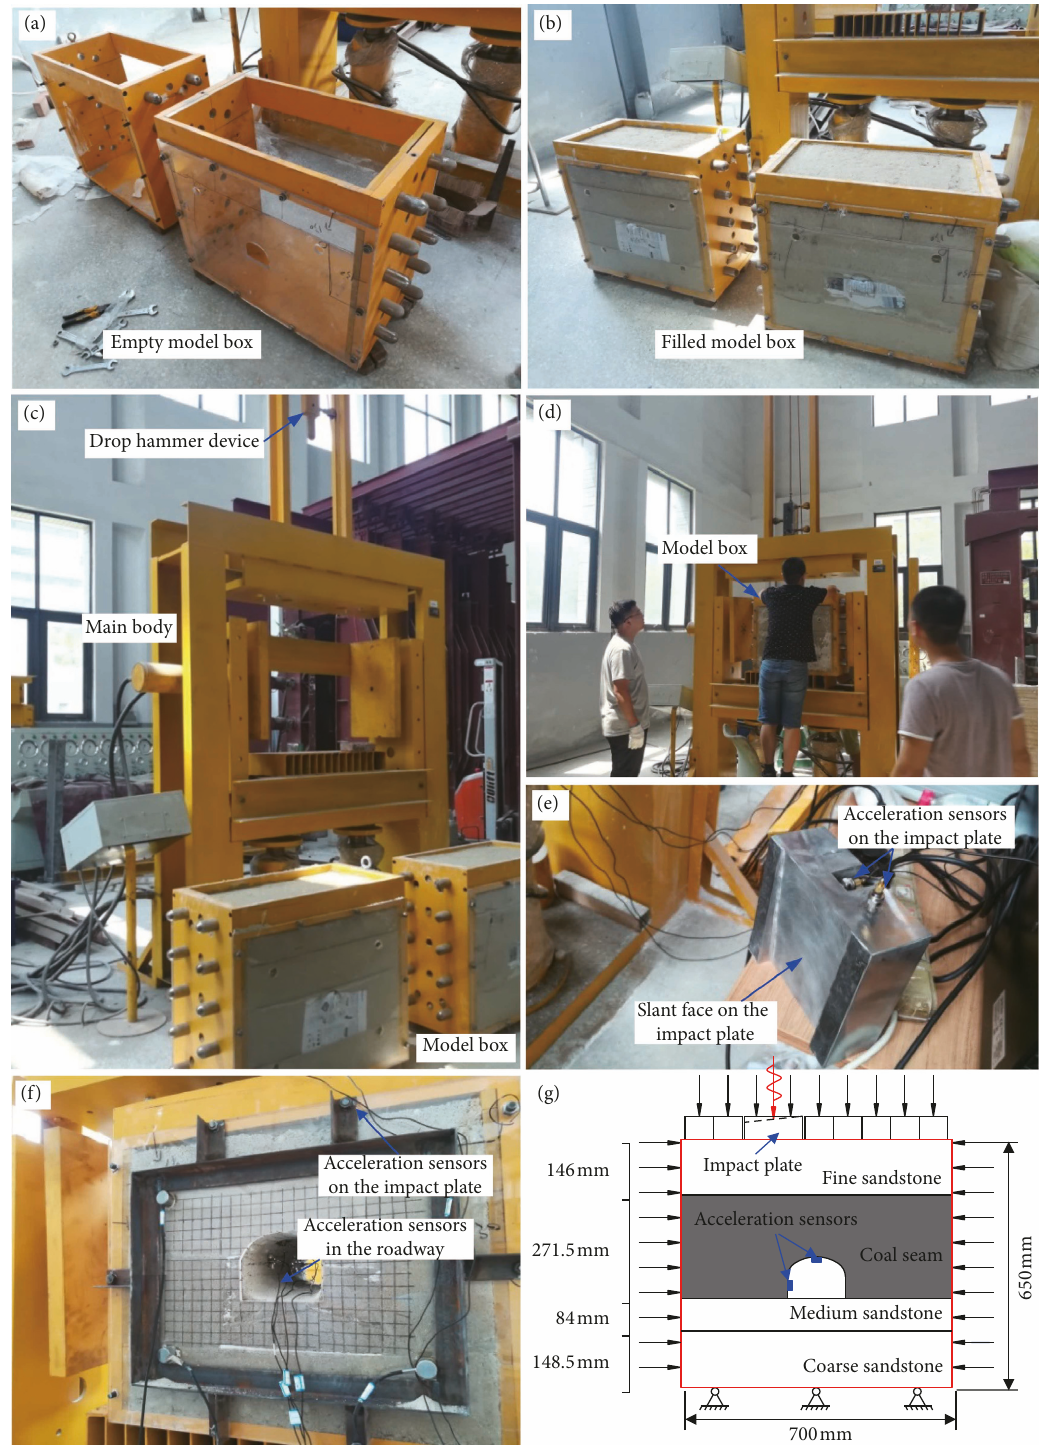
Figure 5: Model building procedure: (a) removing the empty model box from the facility, (b) filling the model box with model materials, (c) air-drying the model, (d) returning the model box to the facility, (e) putting the impact on top of the model, (f) installing sensors and applying loads, and (g) the schematic diagram of the test